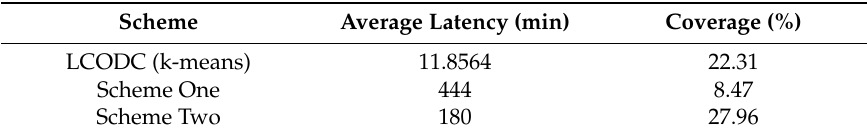
Table 3. Comparison with other